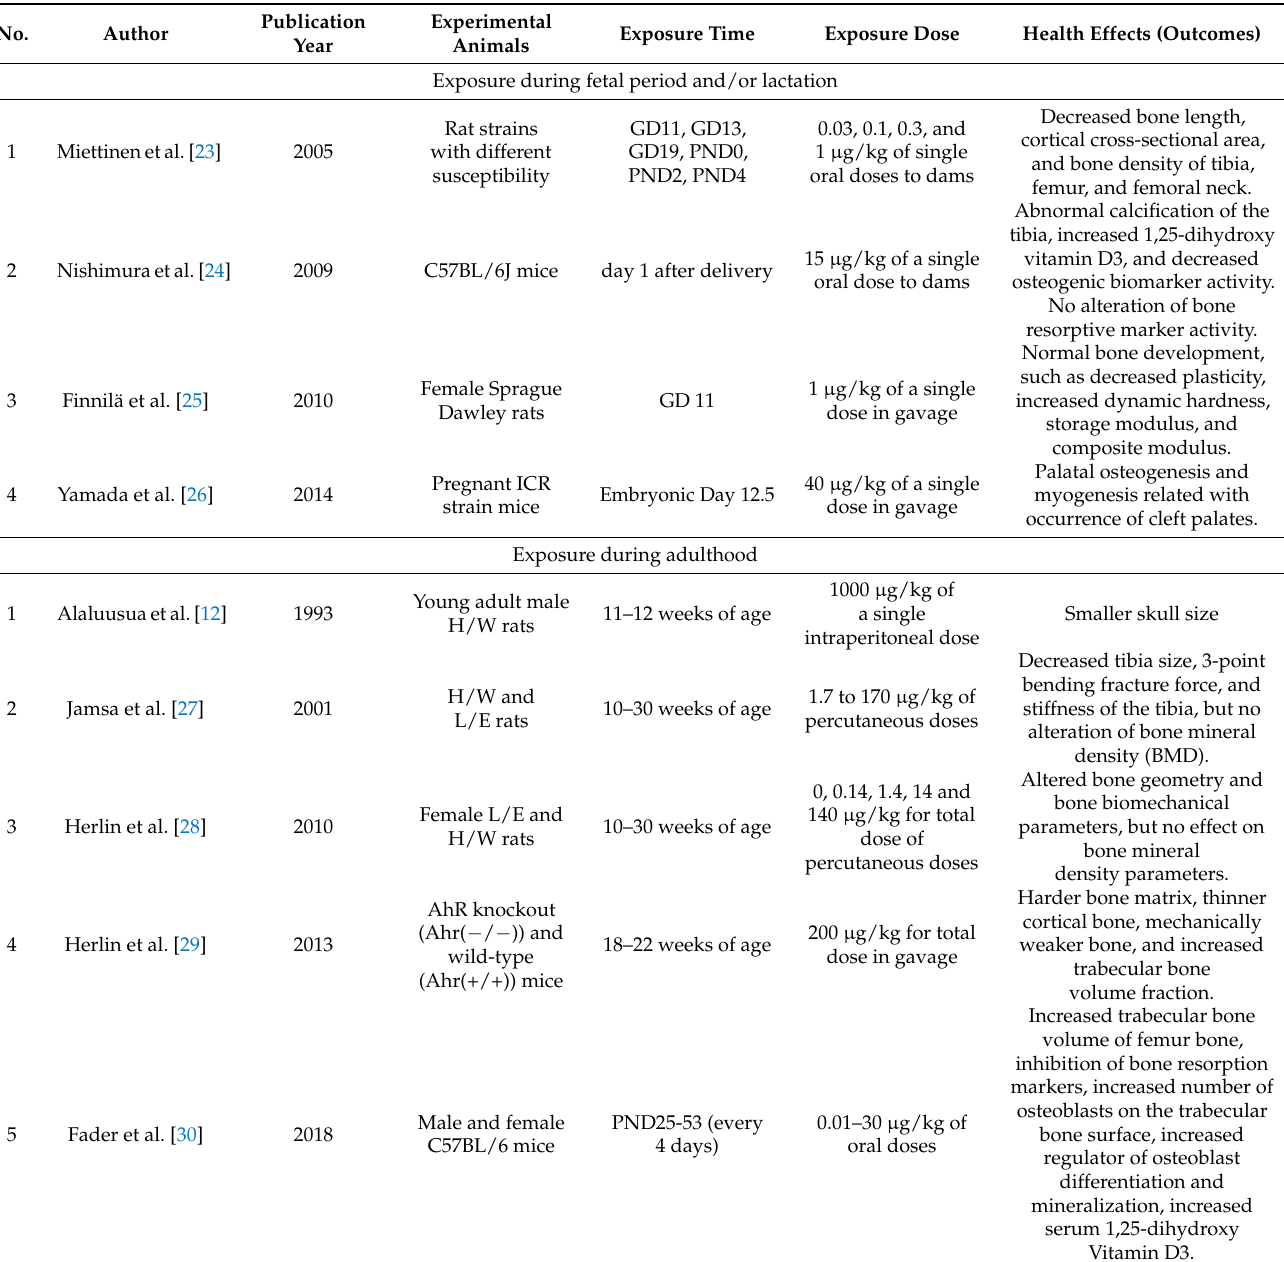
Table 3. Effects of dioxins on bones in